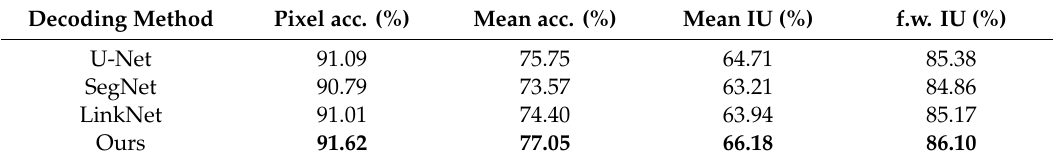
Table 3. Comparison of di ff erent decoding methods in our architecture. (The best results are bold) Decoding